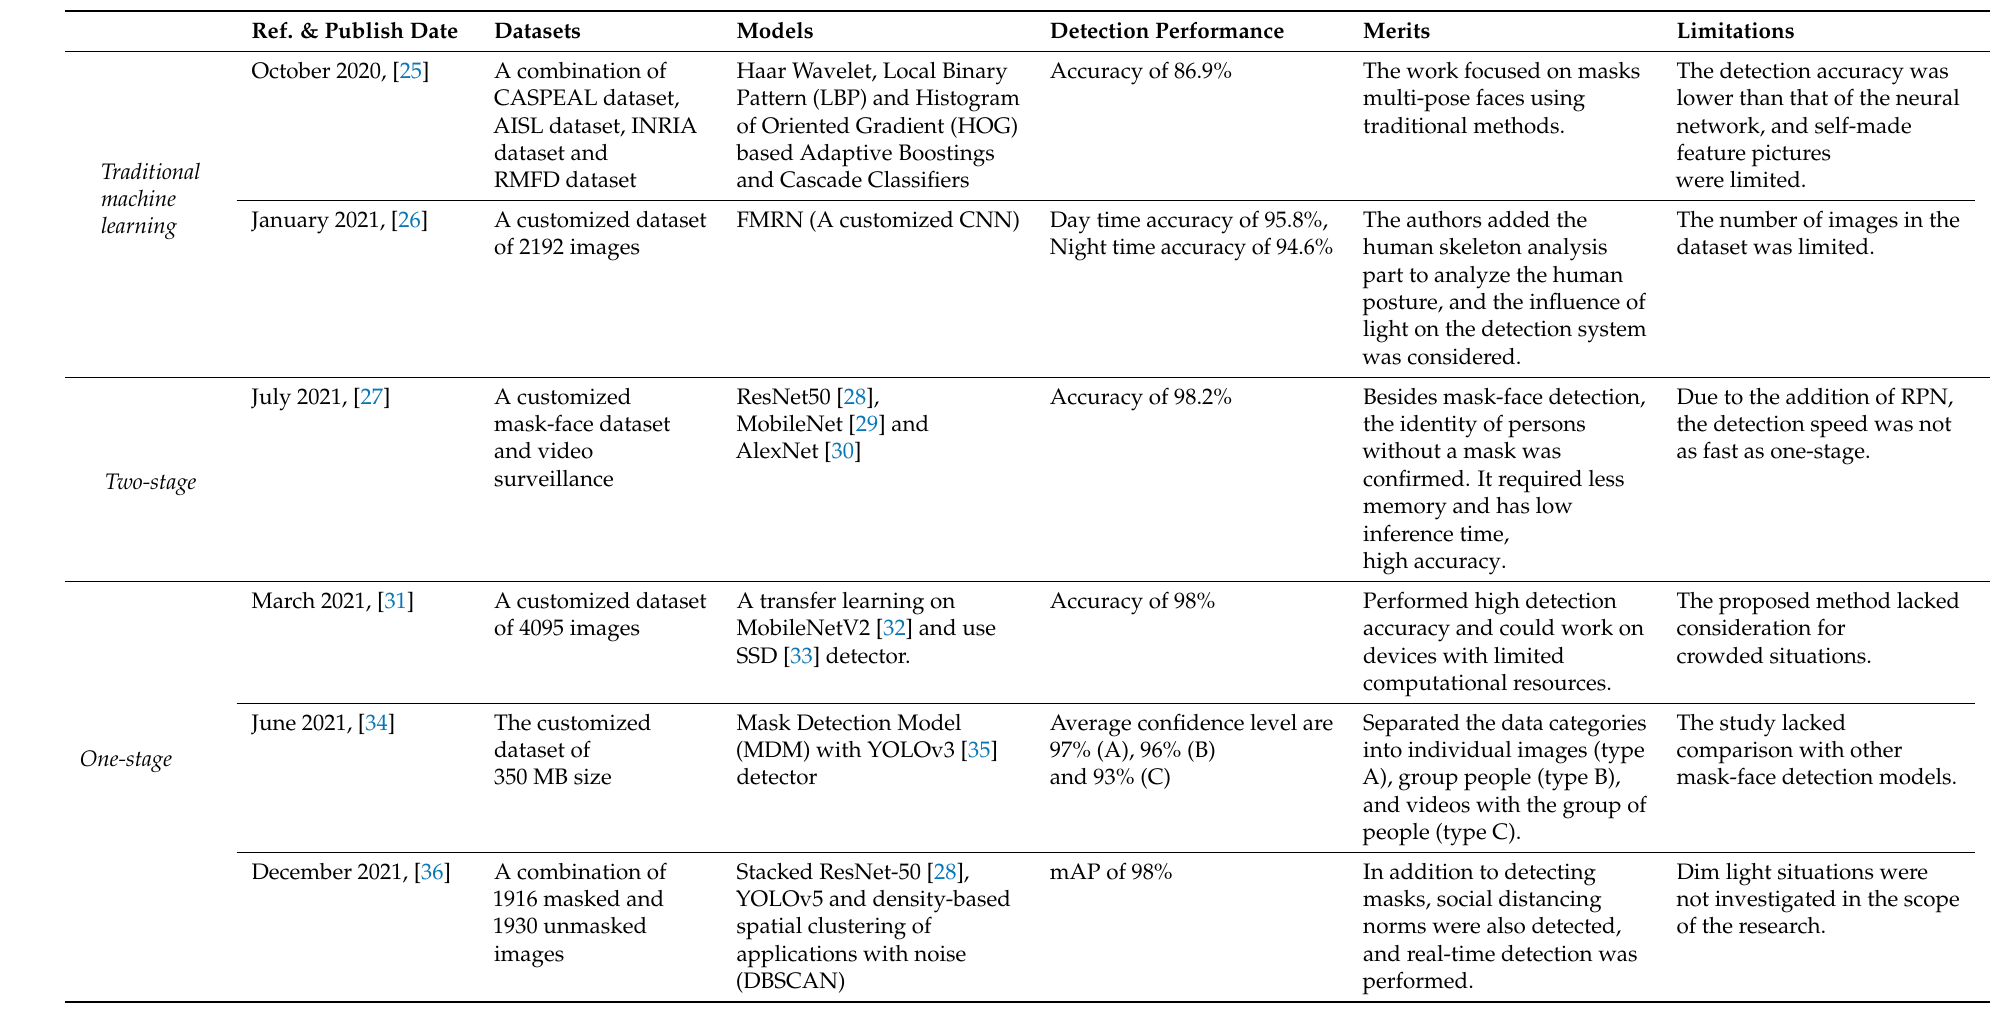
Table 2. Summary of 2-class mask-face detection